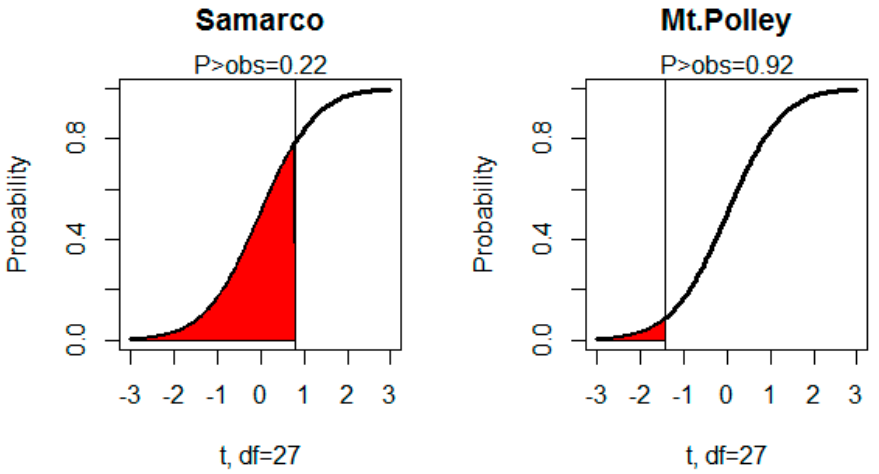
Figure 2. t distributions showing the probability of exceedance of the Samarco and Mt. Polley observed D max and the distributions obtained with model D max .3 around the predicted mean value of D max in the log space .